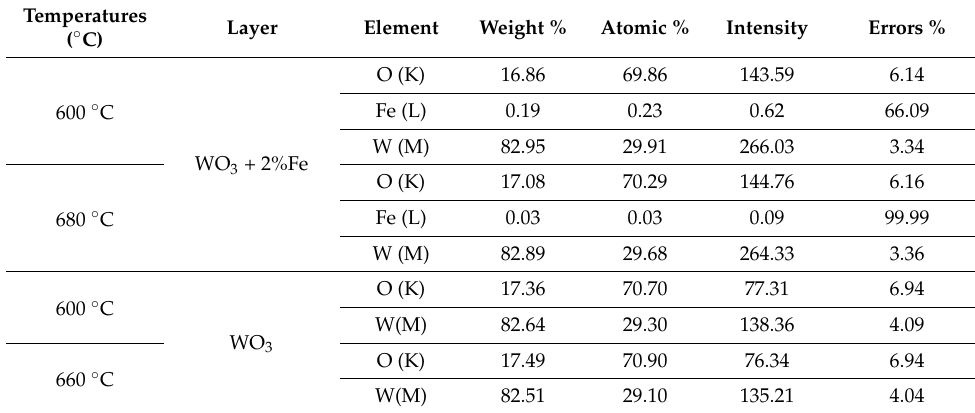
Figure 10. The EDX measurements for WO 3 + 2% Fe grown at 4 h deposition time. ( a ) T = 600 ◦ C; ( b ) T = 680 ◦ C. Table 3. The EDX species of the 2 %Fe doped WO 3 and pure WO 3